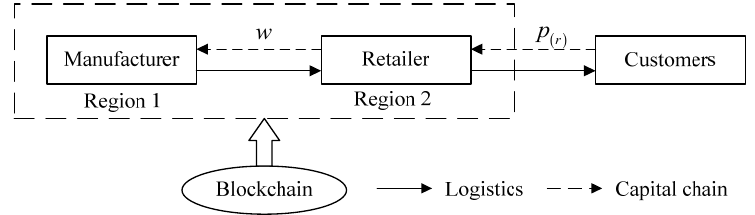
Figure 1. The structure and interaction process of FPSC system in Strategy NN.